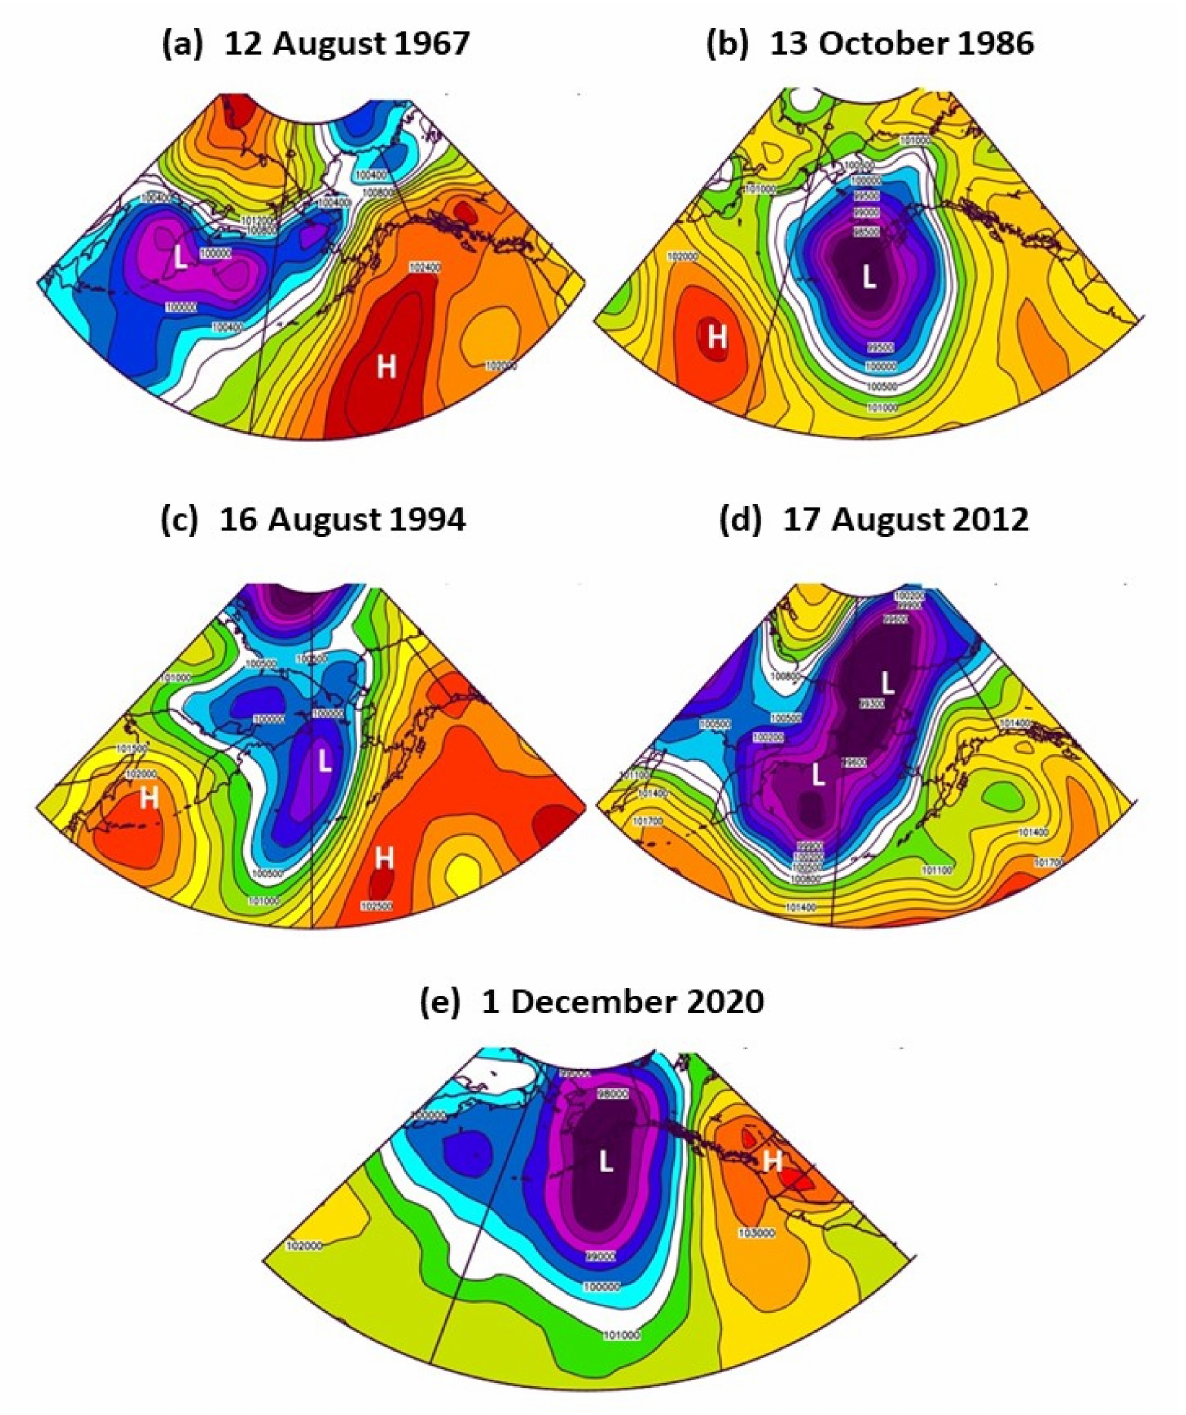
Figure 5. Sea level pressure patterns during heavy precipitation associated with the five flood events: ( a ) Fairbanks, 12 August 1967; ( b ) Seward, 13 October 1986; ( c ) Allakaket/Bettles, 16 August 1994; ( d ) Kivalina, 17 August 2012; ( e ) Haines, 1 December 2020. White, blue and purple denote progressively lower pressures, while yellow, orange and red denote progressively higher pressures. (Color scale values vary among the